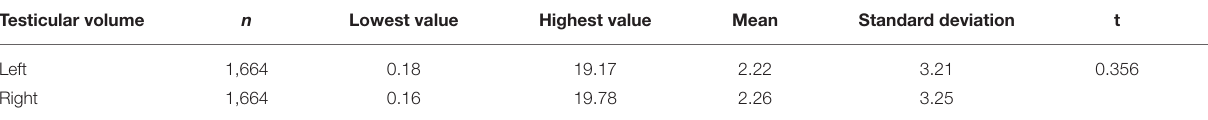
TABLE 2 | The statistical parameters of testicular volume (ml) and the result of t -test. Testicular volume